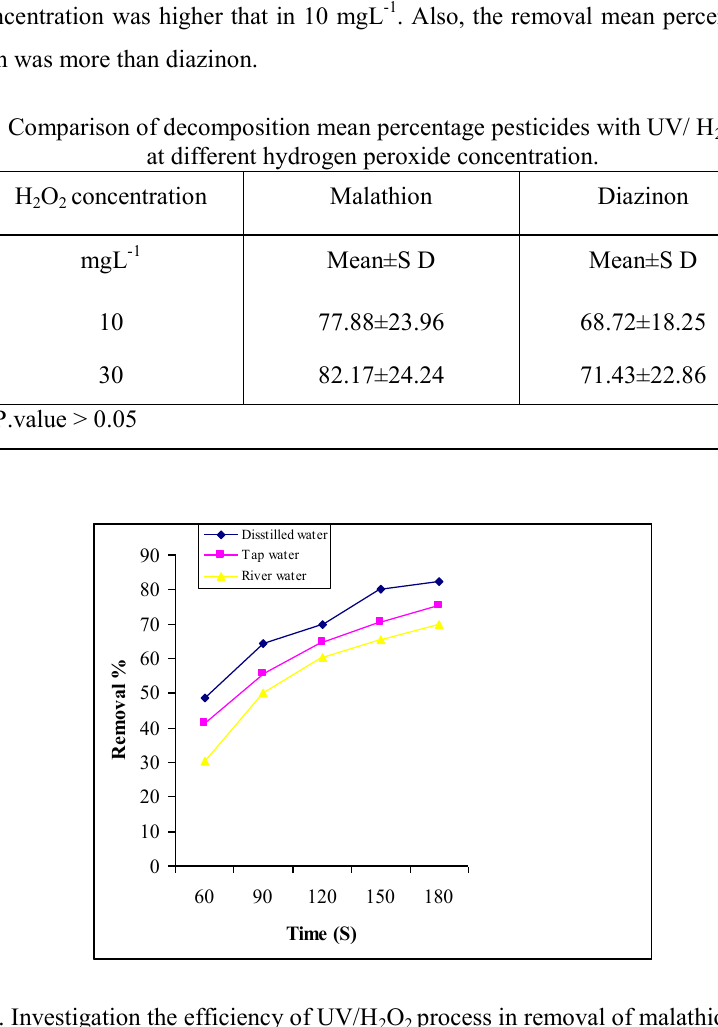
O process in removal of malathion from 2 2